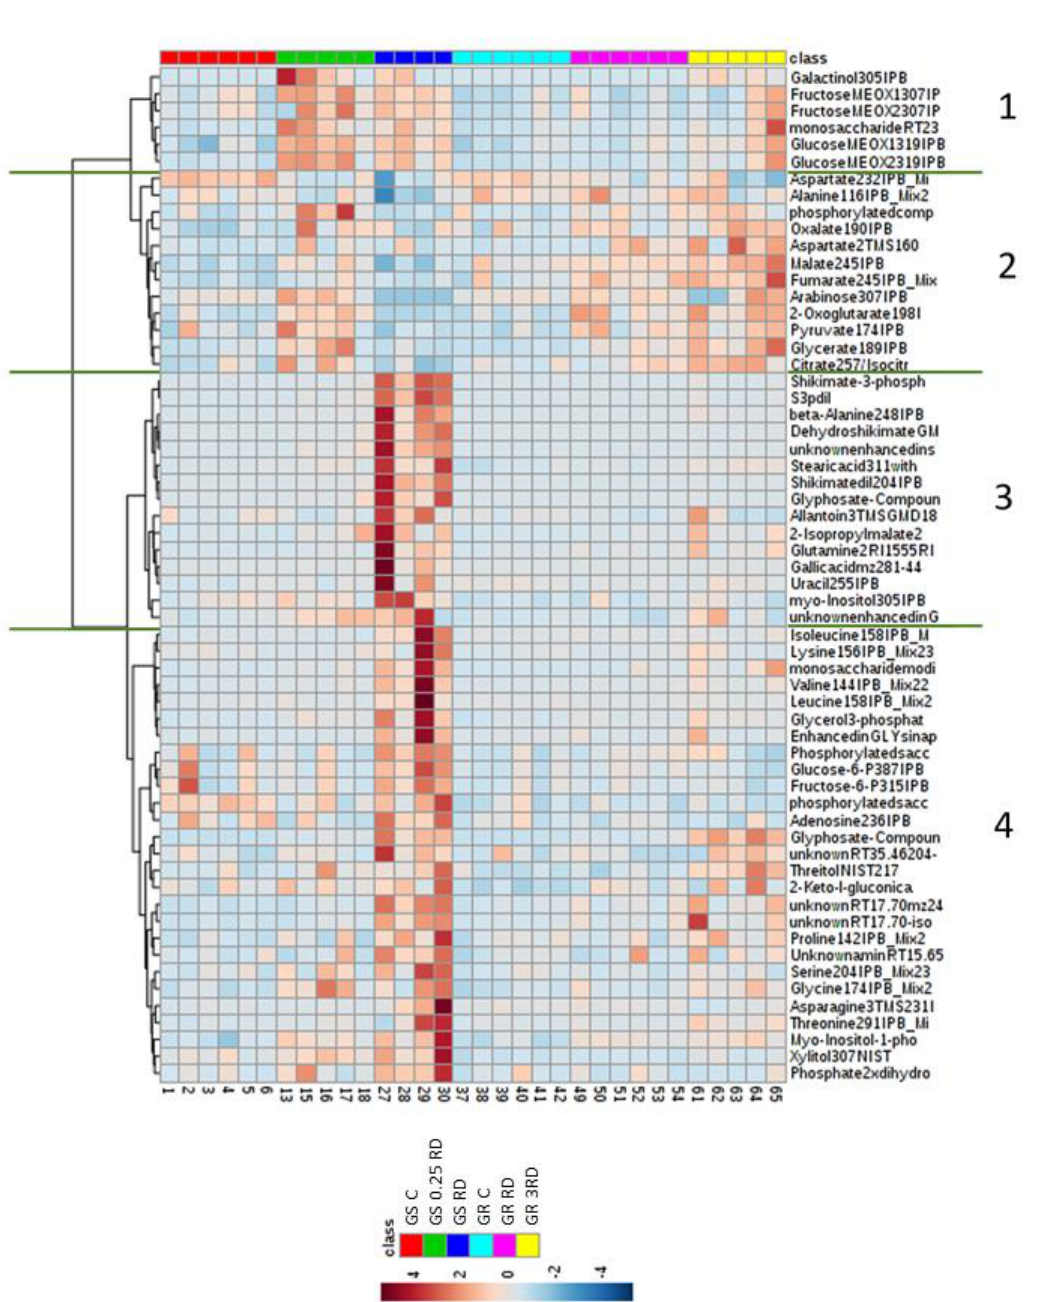
Figure 3. Heat map one-way hierarchical clustering (Clusters 1–4) of the ANOVA (Tukey) significantly different polar metabolites detected by GC–MS in glyphosate-sensitive (GS) and glyphosate-resistant (GR) Amaranthus palmeri plants. Plants were not treated (GS C and GR C) or treated with glyphosate at two doses: The GS population was treated with 0.25or 1 the field recommended dose (RD); the GR population was treated with 1 and 3 RD. The algorithm for heat map clustering was based on the Euclidean distance measure for similarity.